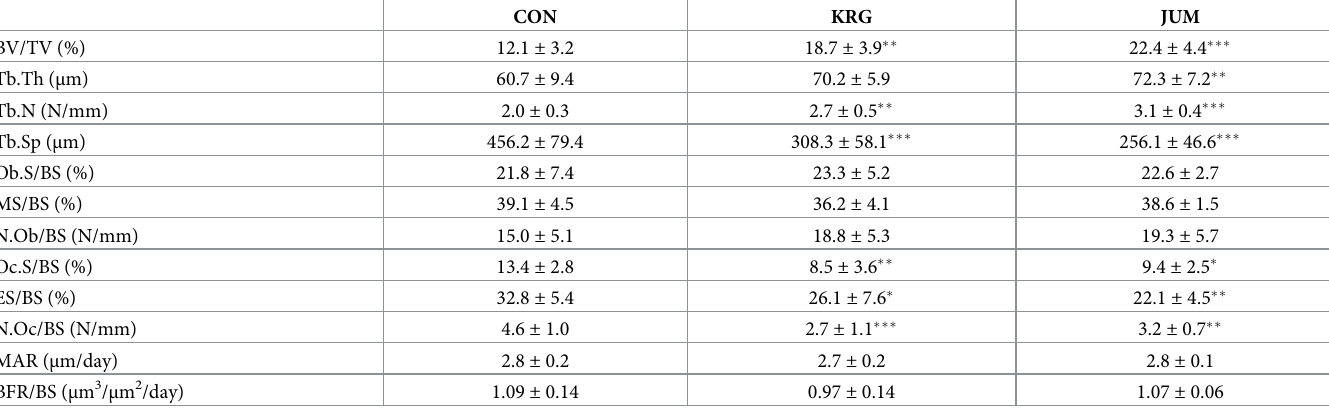
Table 2. Static and dynamic bone histomorphometric parameters of the distal femoral